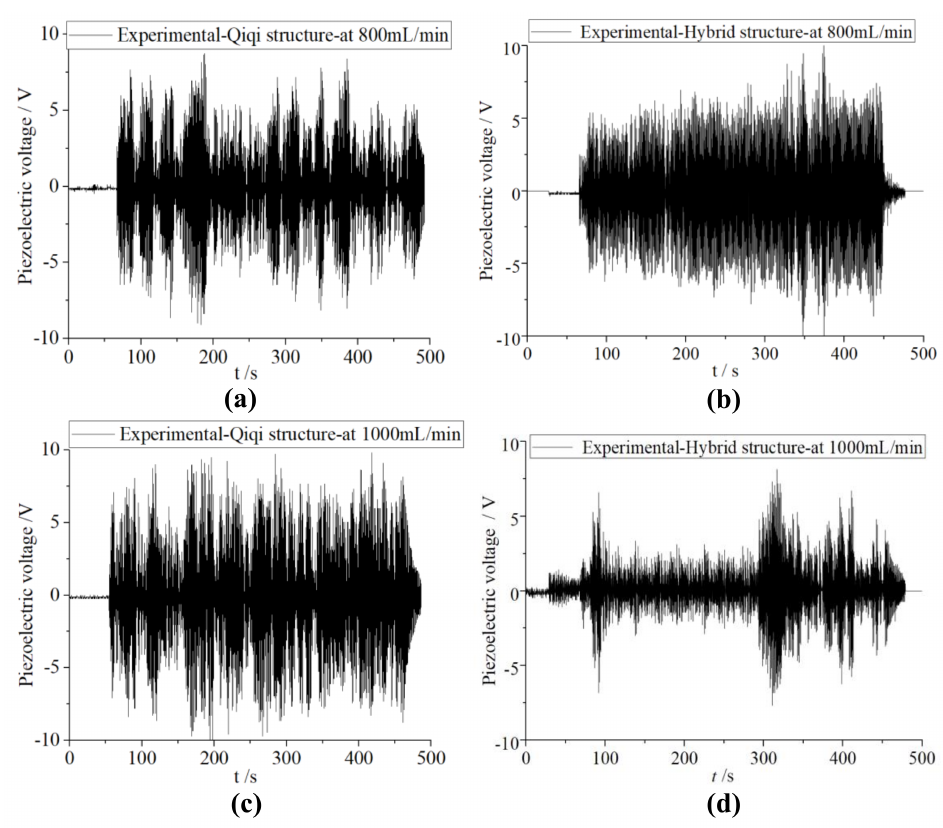
Figure 10. ( a ) Experimental voltage of the Qiqi structure at 800 mL/min; ( b ) experimental voltage of the hybrid structure at 800 mL/min; ( c ) experimental voltage of the Qiqi structure at 1000 mL/min; ( d ) experimental voltage of the hybrid structure at 1000